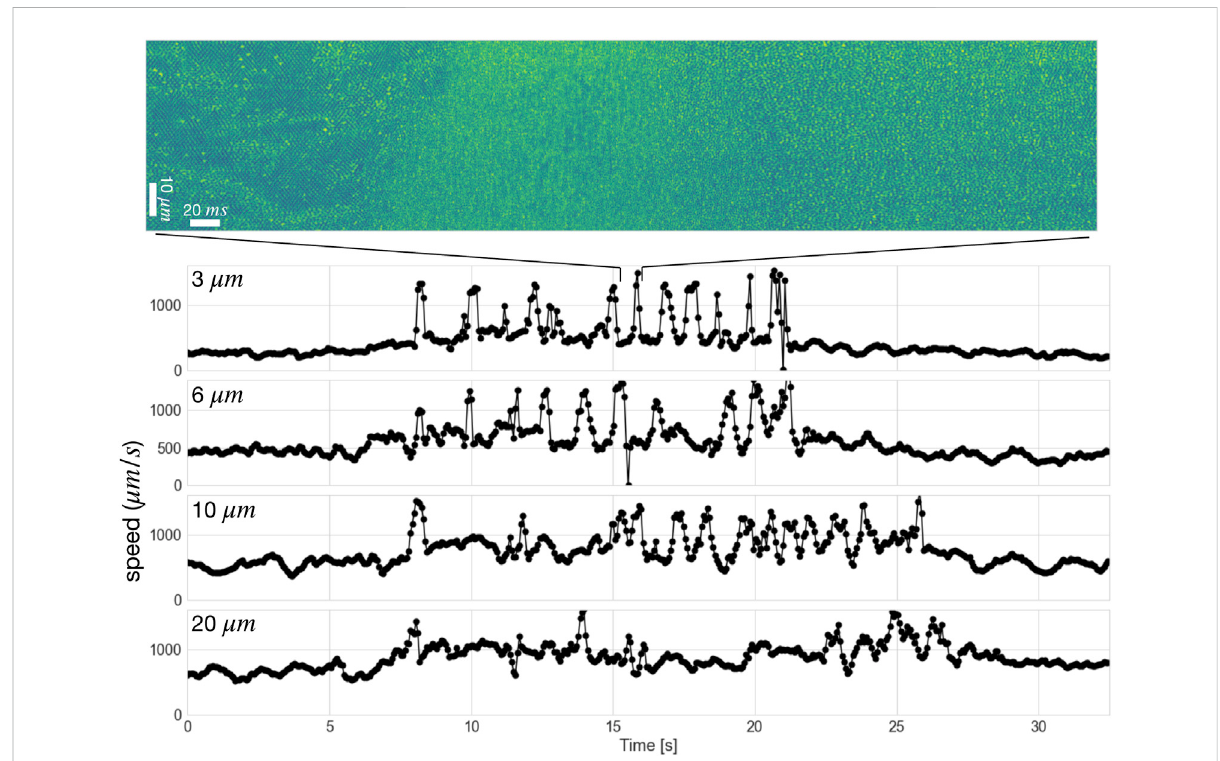
FIGURE 11 Timeseries of speed for 100 Pa applied stress at heights of 3, 6, 10, and 20 μ m during one burst of high speed events. The image shows a kymograph from a single event. The initial times are shifted so the bursts start at approximately the same